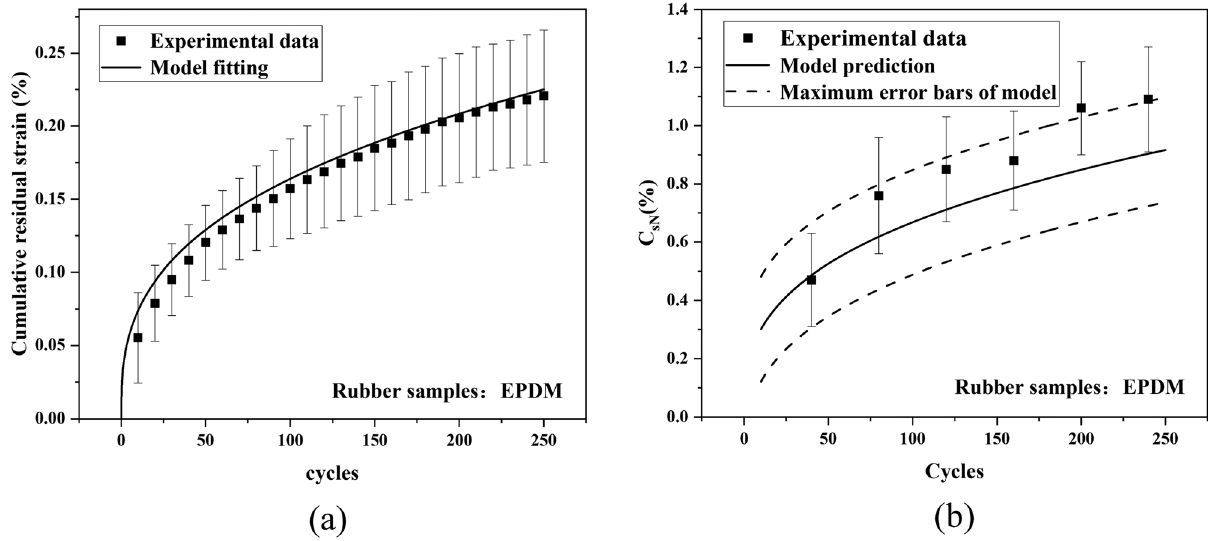
Figure 14: Accumulated residual strain ( a ) and cycle - induced compression set prediction ( b ) of EPDM samples.